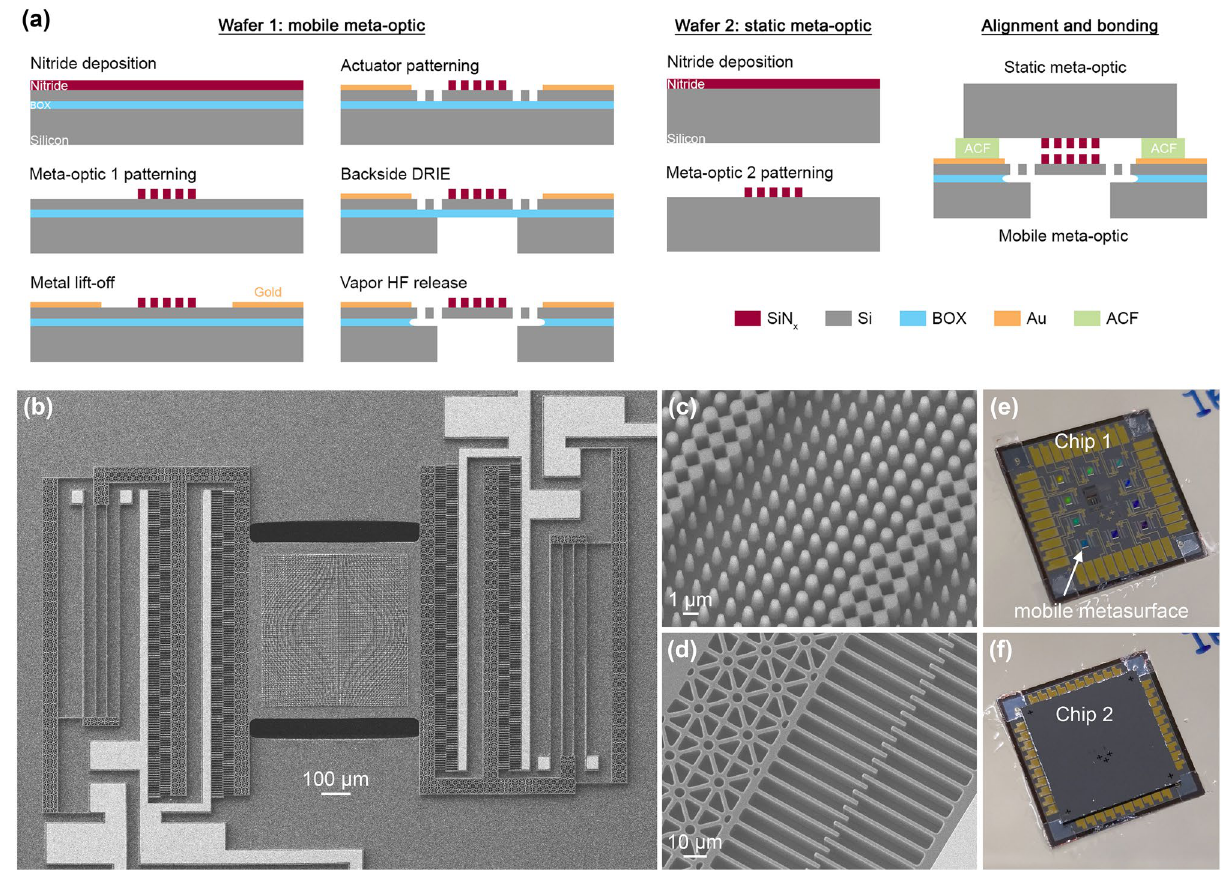
Figure 2. Device fabrication. ( a ) Summarized fabrication process flow. ( b ) Scanning electron microscopy (SEM) image of an Alvarez meta-optic integrated with a MEMS tuning platform. ( c ) Close-up view of the silicon nitride nanoposts sitting on the central silicon platform. ( d ) Comb-drive details showing the part of the mobile flexure backbone and interdigitated finger array. ( e ) Fabricated chip carrying mobile Alvarez meta-optics on electrostatic actuators. ( f ) Final assembled stack with another chip carrying static Alvarez meta-optics aligned and bonded on